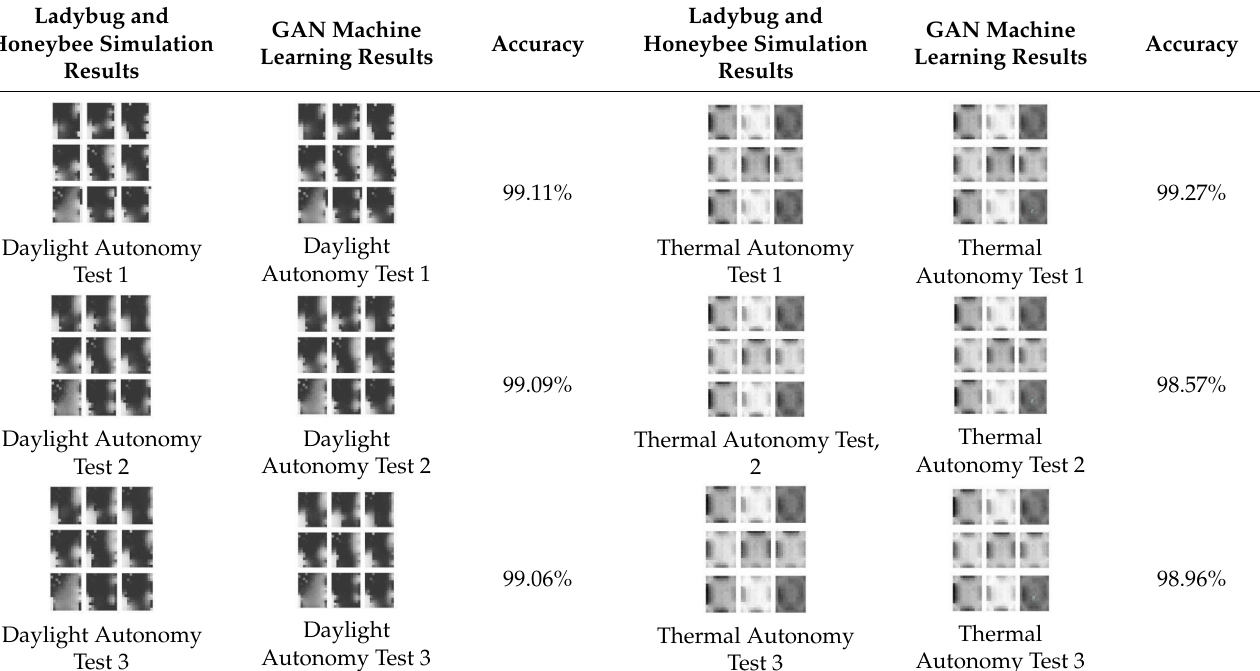
Table 2. Accuracy of the machine learning model based on